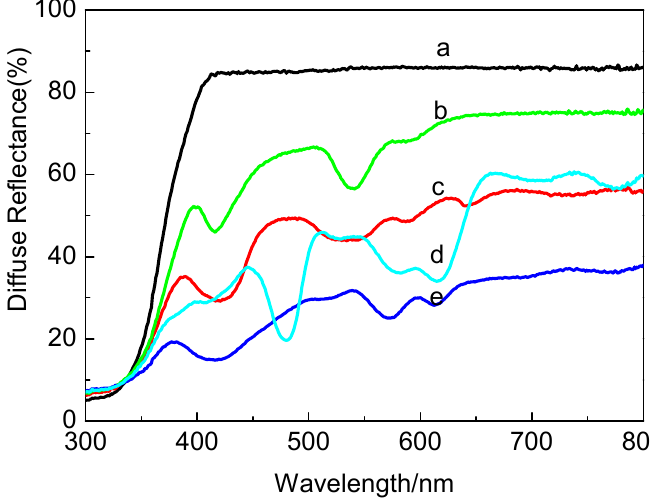
(P25) and metalloporphyrins-TiO 2 , (d): MnP-TiO 2